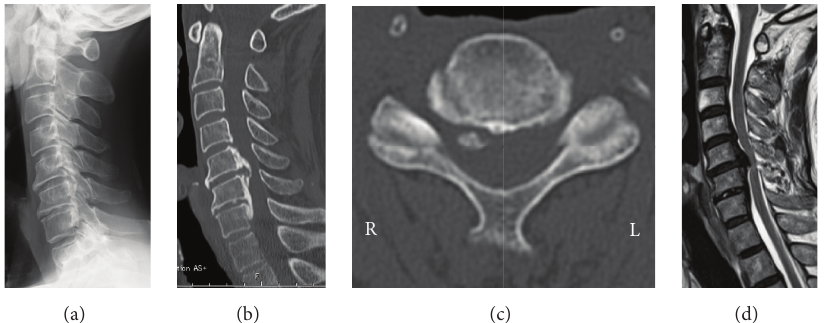
Figure 1: Preoperative radiological findings. (a) and (b): mixed type ossification of the posterior longitudinal ligament was observed on the lateral view of the cervical spine radiograph and sagittal view on computed tomography (CT). Alignment was lordotic and ossification did not exceed the “K-line.” (c): Foraminal stenosis was detected at bilateral C4/5 (1.5mm on the left side and 2.5 mm on the right side) on axial